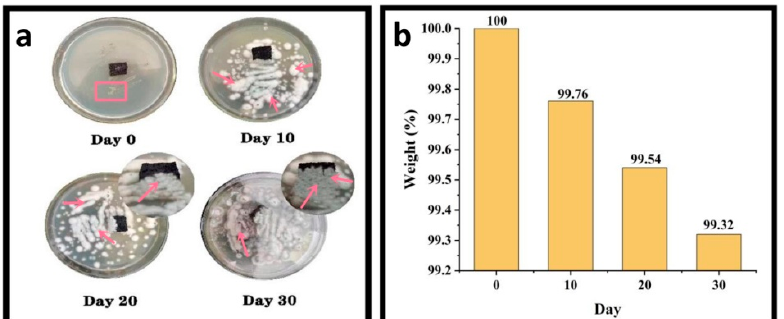
Figure 8. Optical images showing biodegradability of TSGFA-based foam: ( a ) activity development of Penicillium sp. over 30 days; ( b ) weight loss of the foam over 30 days.